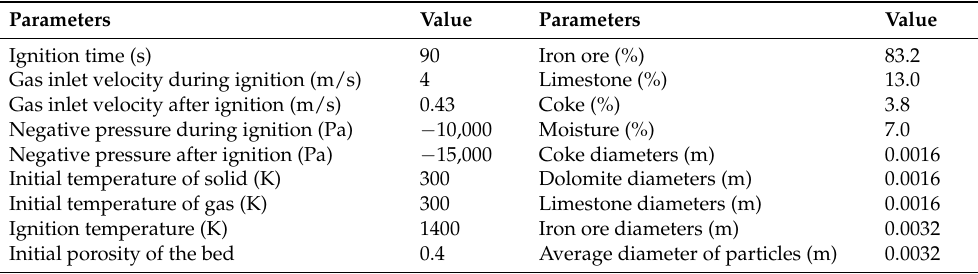
Table 3. Boundary and initial